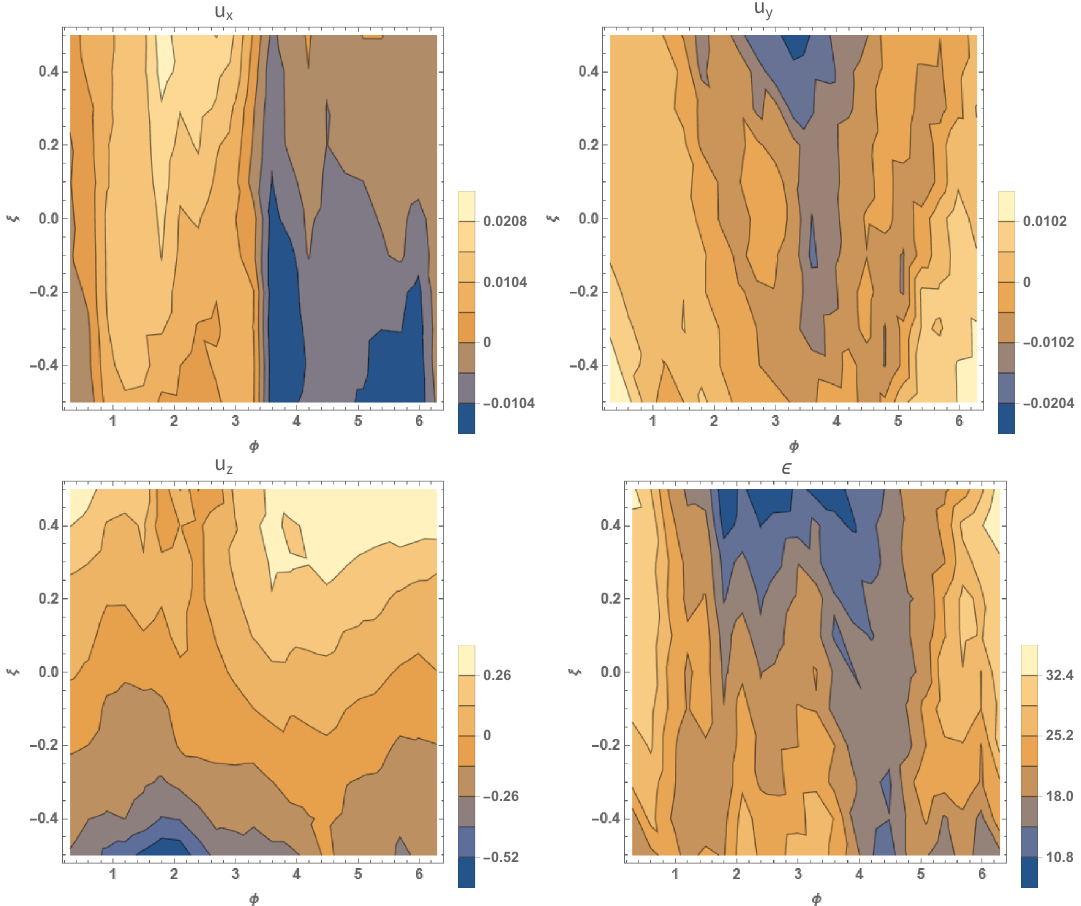
Figure 9 . The fluid velocity and the proper energy density in the hydro-subregion R defined in (4.5) as a function of rapidity ξ and φ given in (4.5). The first row corresponds to the transverse fluid velocity with u x corresponding the left and u y to the right plot. The second row shows the longitudinal fluid velocity u z on the left and the proper energy density, which is given in units of [GeV 4 ], on the